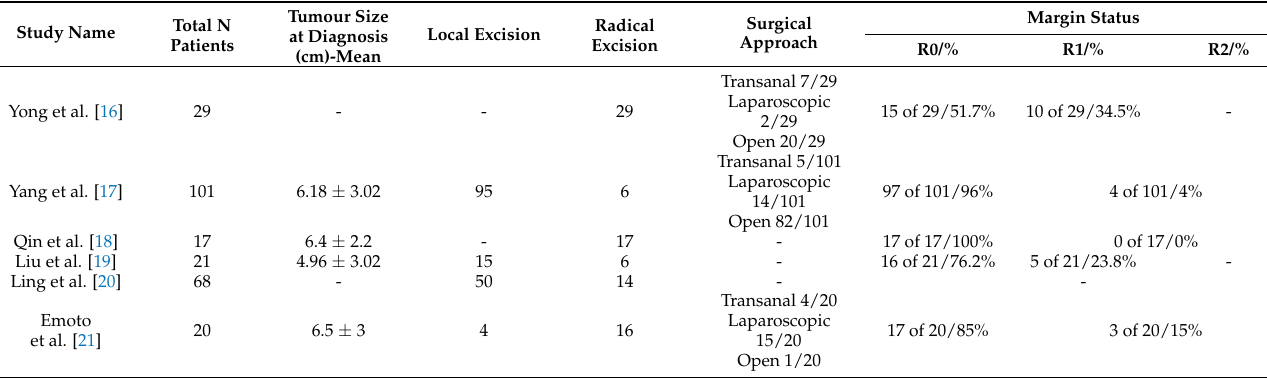
Table 2. Summary of Surgical